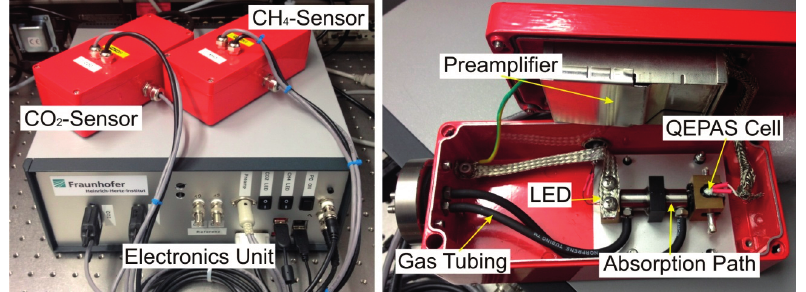
Figure 3. Picture of the biogas detection system with electronics unit and both absorption-QEPAS sensors ( Left ); and photograph of the interior of the methane sensor ( Right